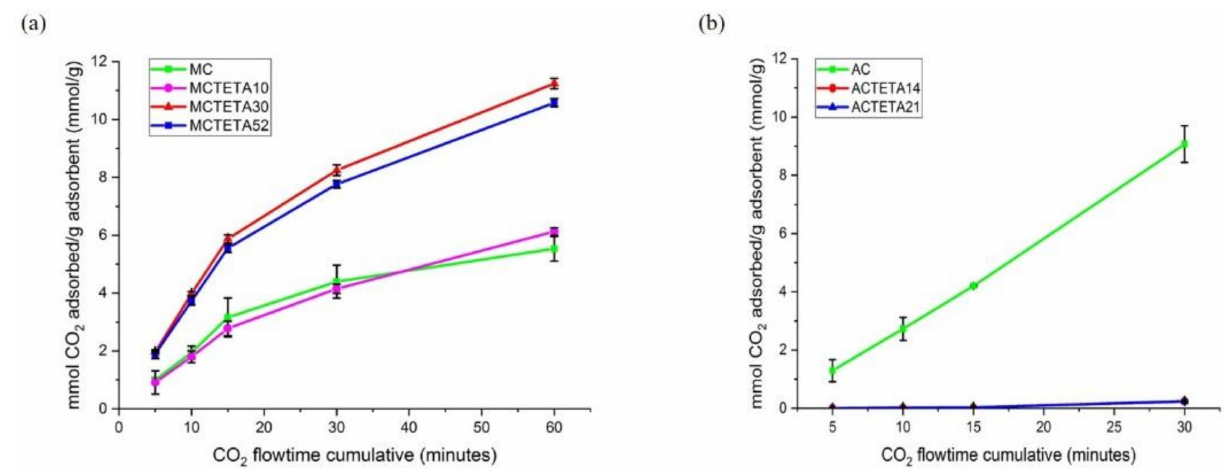
Figure 5. CO 2 adsorption curve for TETA-functionalized ( a ) MC and ( b ) AC at pressure (P) of 5 atm at room temperature and with a CO 2 flow of 50